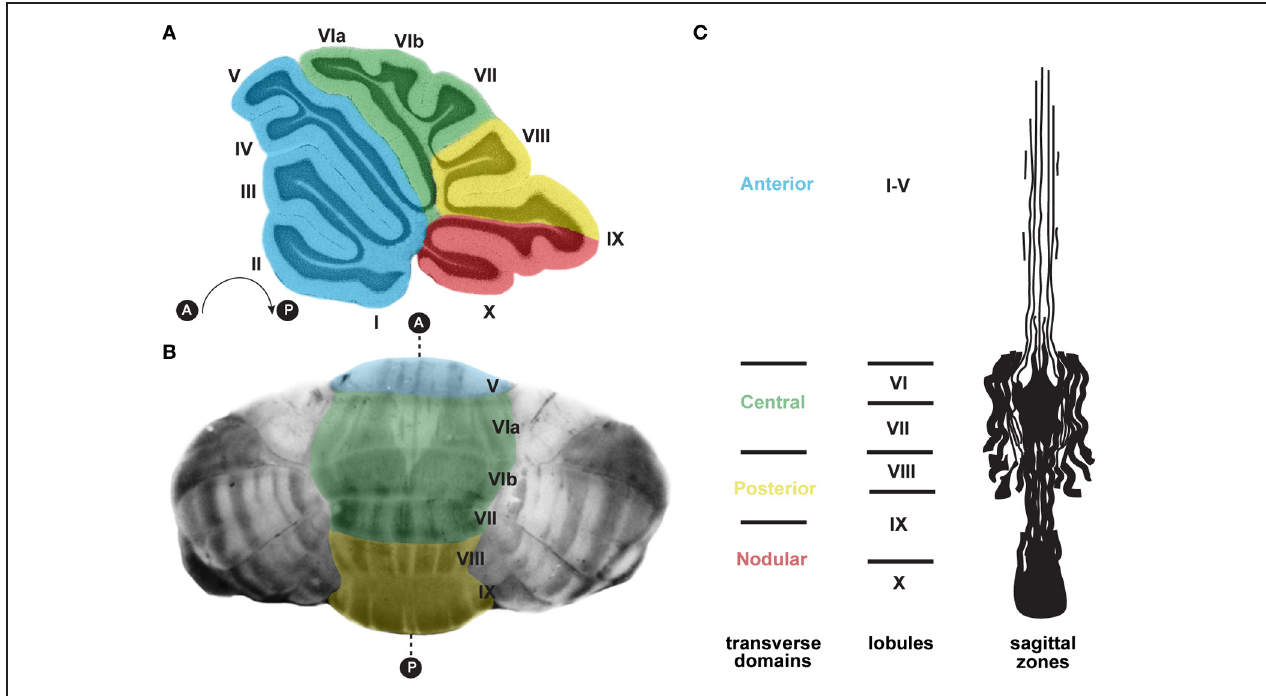
FIGURE 3 | (A) Schematic of a sagittal section cut through the cerebellar vermis revealing the stereotypical foliation pattern, which consists of 10 lobules [adapted with permission from White and Sillitoe (2013)]. The cerebellum can be further divided along the anterior–posterior axis into four transverse domains: anterior (blue; lobules I–V), central (green; lobules VI and VII), posterior (yellow; lobules VIII and anterior IX), and nodular (red; lobules posterior IX and X) (Ozol et al., 1999). (B) In the